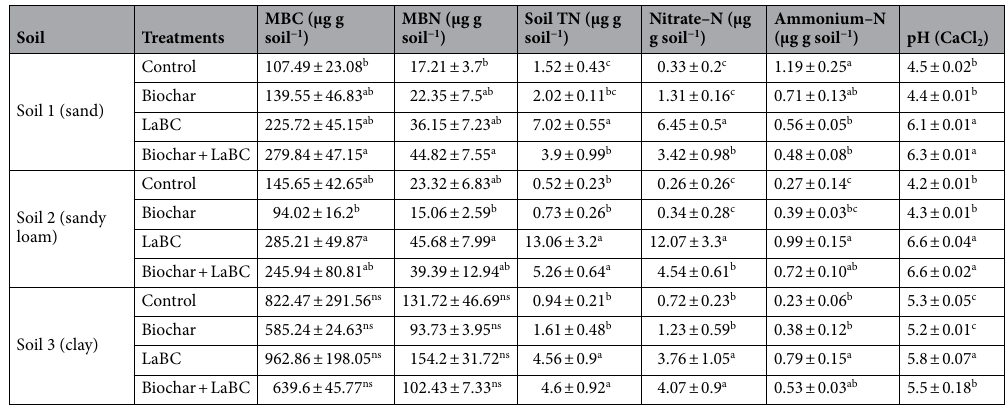
Table 2. Effect of soil amendments (Biochar, LaBC, Biochar + LaBC) on the soil physico-chemical parameters of three soils after 8 weeks in the presence of subterranean clover. MBC (microbial biomass C); MBN (microbial biomass N); TN (total N). Values presented are means ± standard error of the mean, n = 3; letters in superscript show treatments that differ significantly.